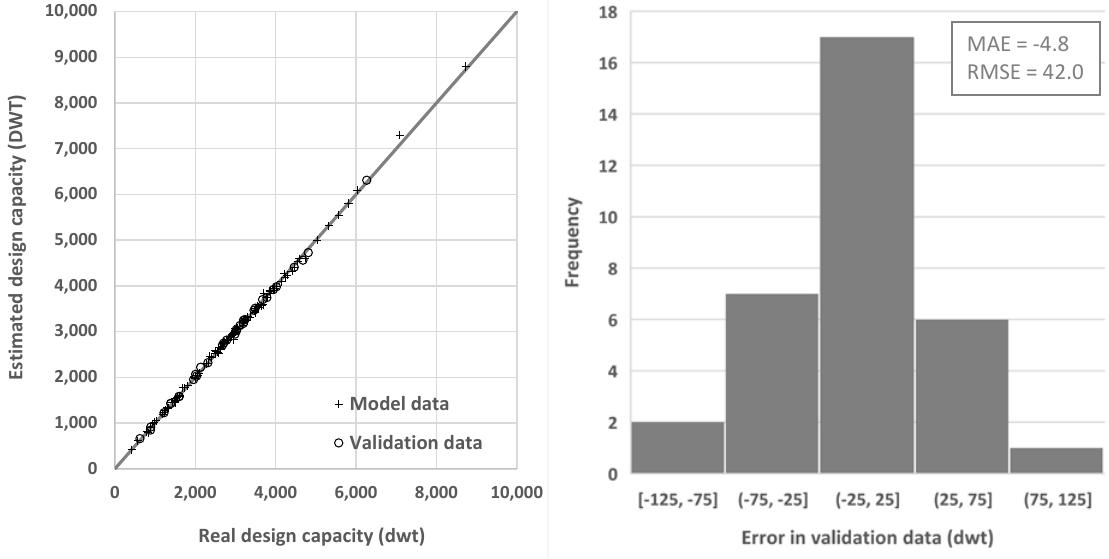
Figure 11. Design capacity model validation and histogram of error